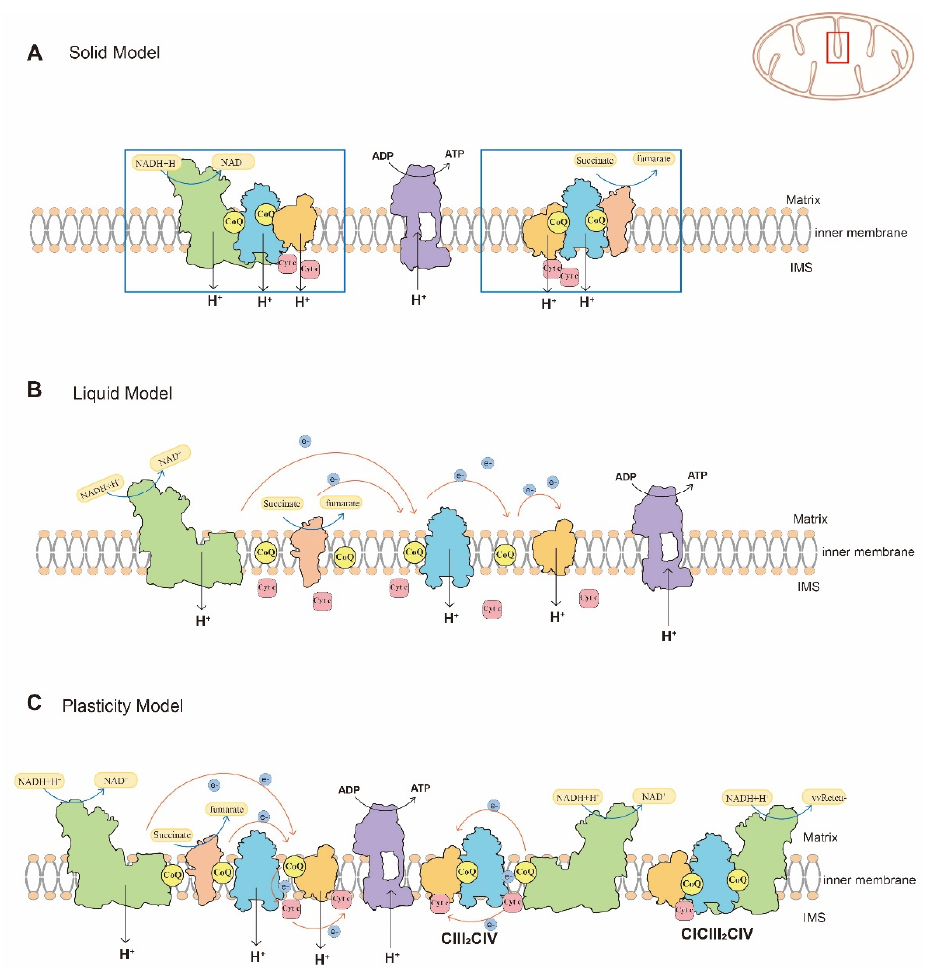
Figure 2. Schematic representation of the different assembly models of the mitochondrial respiratory chain. ( A ) The solid model of mitochondrial respiratory chain. The mitochondrial respiratory chain complexes and electron carriers are anchored within a framework and interact with others tightly to ensure high catalytic activity. ( B ) The liquid model of mitochondrial respiratory chain. Respiratory chain complexes are freely located on the inner mitochondrial membrane and are connected by freely diffusible electron carriers. ( C ) The plasticity model of the mitochondrial respiratory chain. In this model, individual complexes and SCs participate in electron transfer collectively or individually to adapt to the internal environment. The position of cytoplasm, matrix, the intermembrane space (IMS), cristae and the inner membrane are indicated. Green = CI, pink = CII, blue =CIII dimer, orange = CIV, purple = CV.